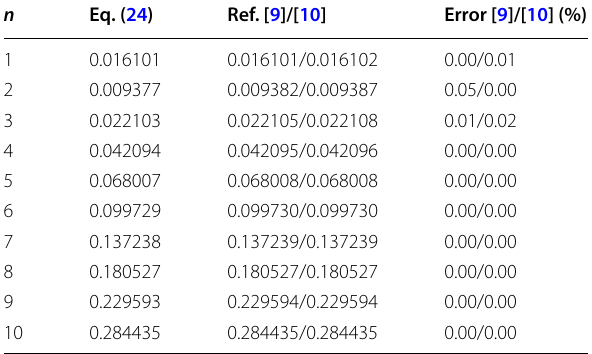
Table 1 Comparison of frequency parameters for the cylindrical shell without pressure with SS-SS boundary